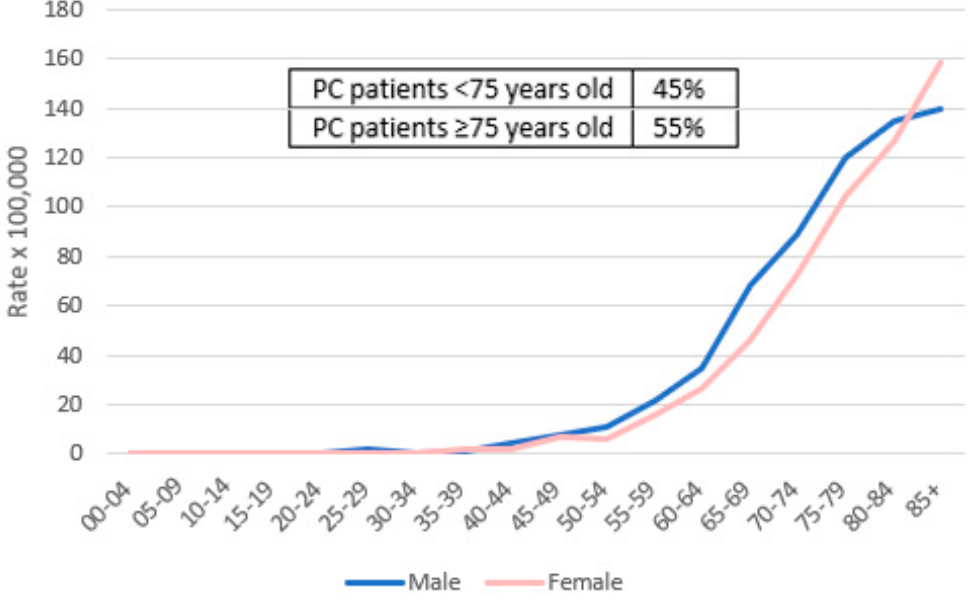
Figure 1. Trend of incidence rates of pancreatic cancer incidence with annual percent change (APC) and 95% confidence interval (CI) in the Veneto region population by sex.